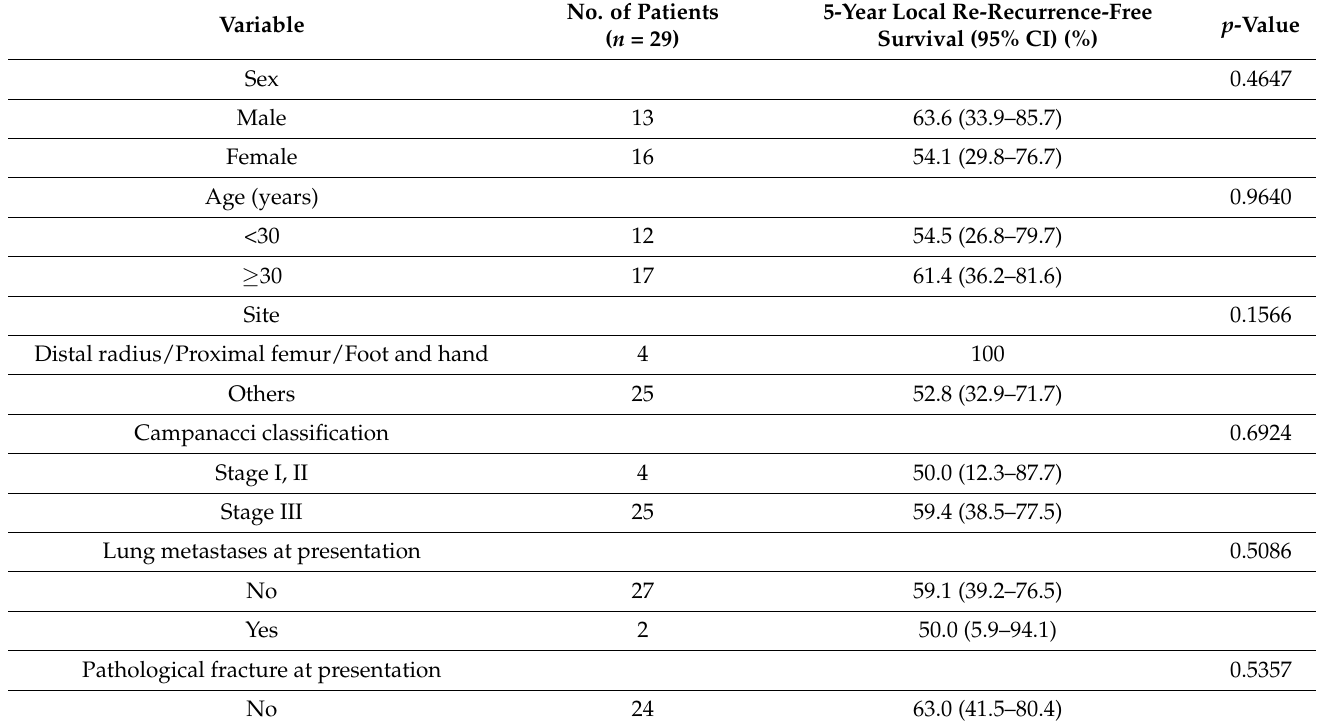
Table 5. Univariate analysis for local re-recurrence-free survival in patients who experienced local recurrence after en bloc resection for GCTB of the